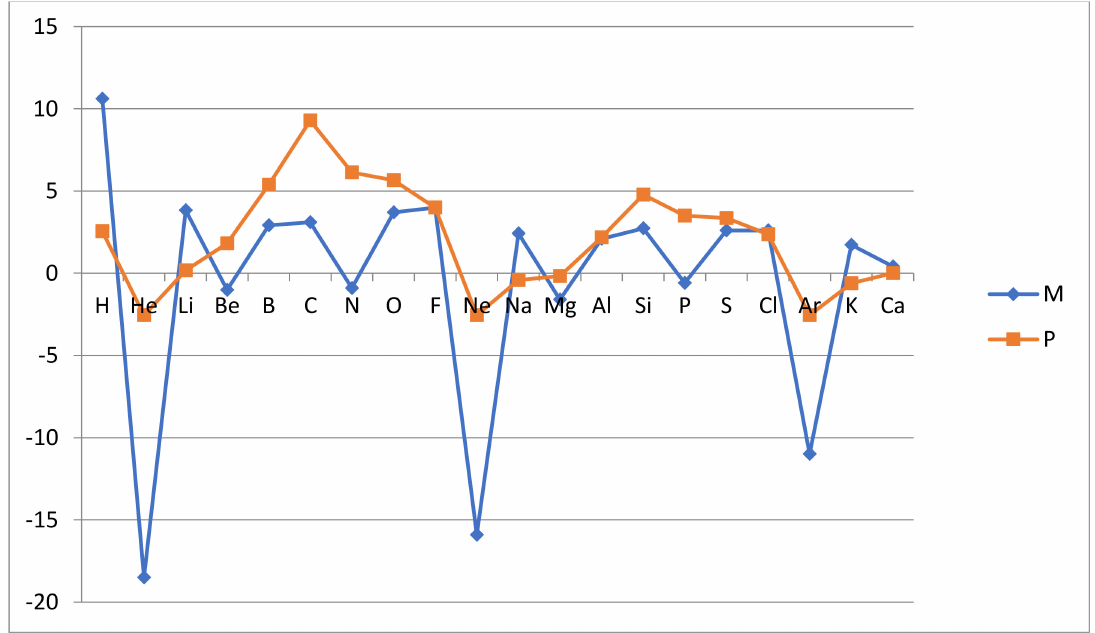
Figure 2. The relative atomic reactivities rAR M (A) and rAR P (A), normalized so that the value for fluorine is 4, are shown for atoms A from H to